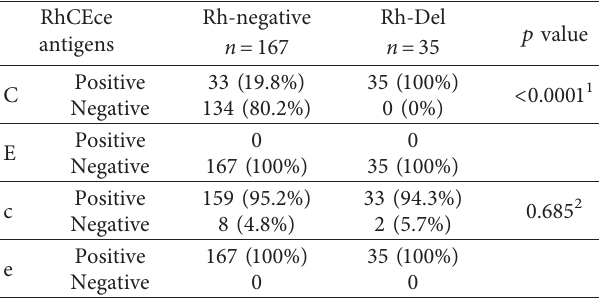
Table 1: Distribution of RhCEce antigens in Rh-negative and Rh- Del phenotype ( N � 202).